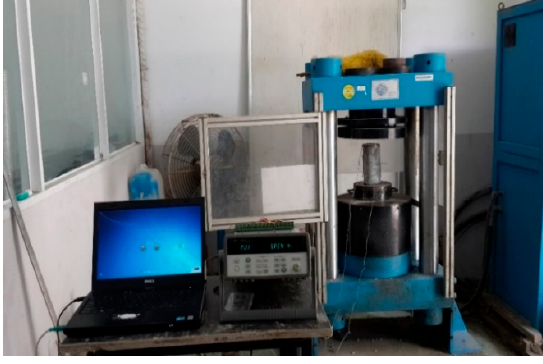
Figure 5. Compressive test.